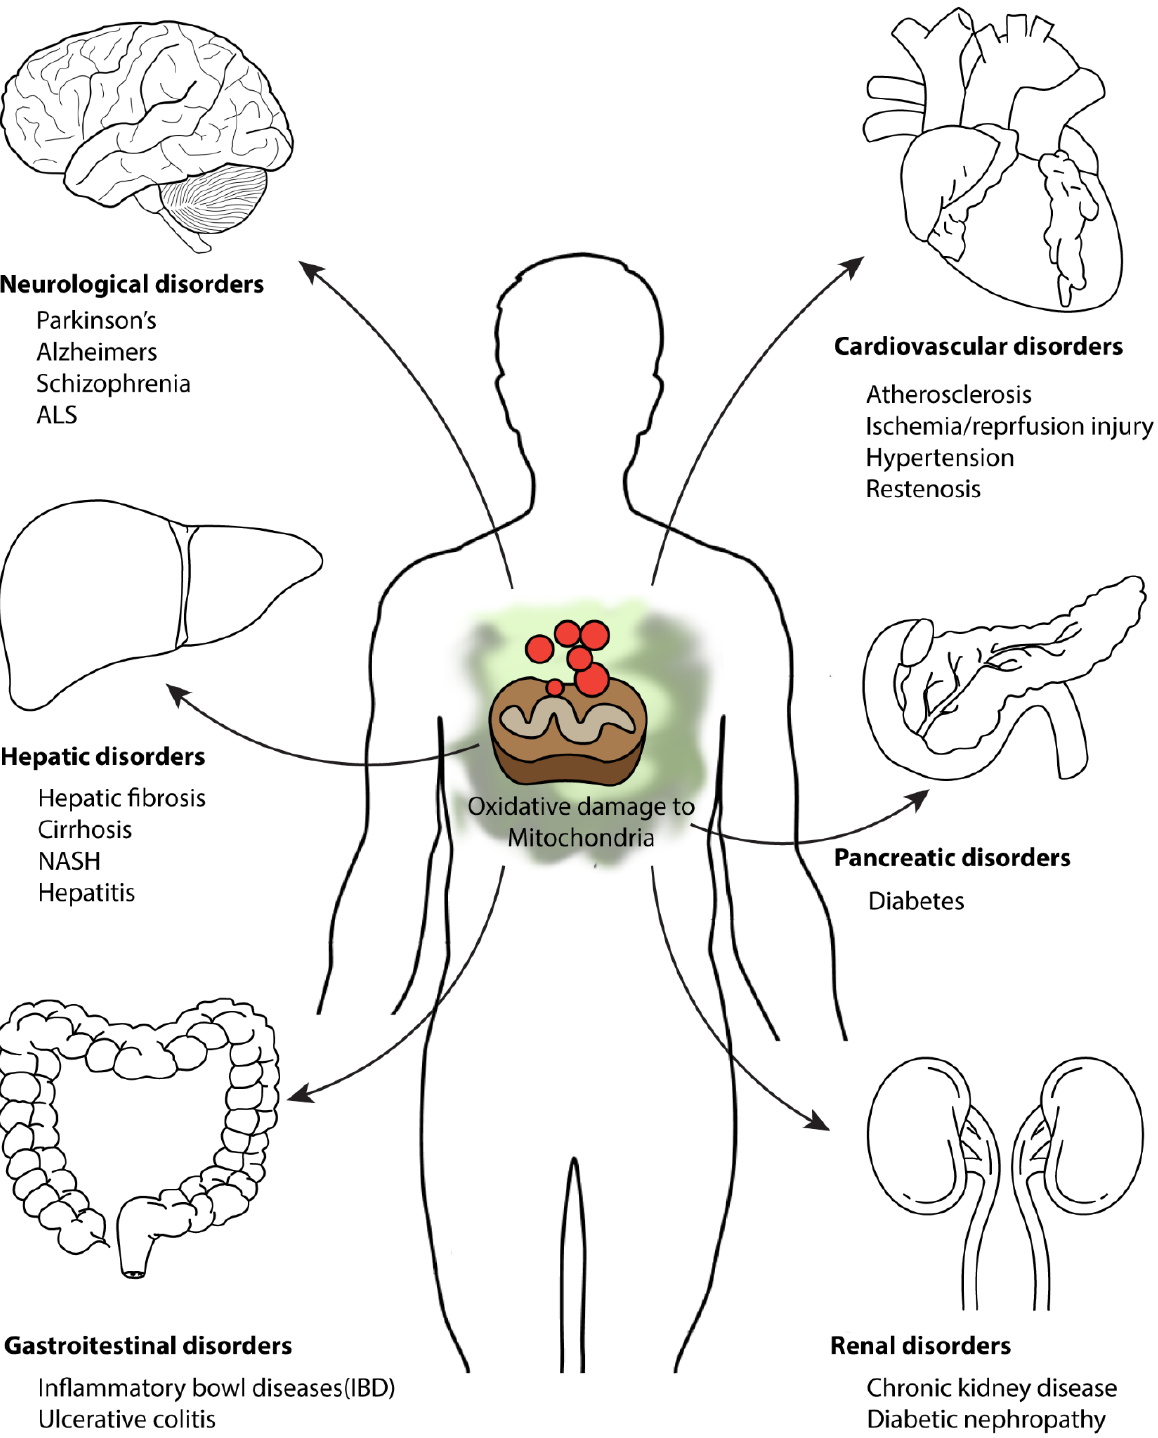
Figure 2: Mitochondrial damage due to overproduction of ROS and its contribution to various disease families. Mitochondrial damage can cause pathogenesis to almost every organ systems of the body including neuronal, hepatic and cardiovascular